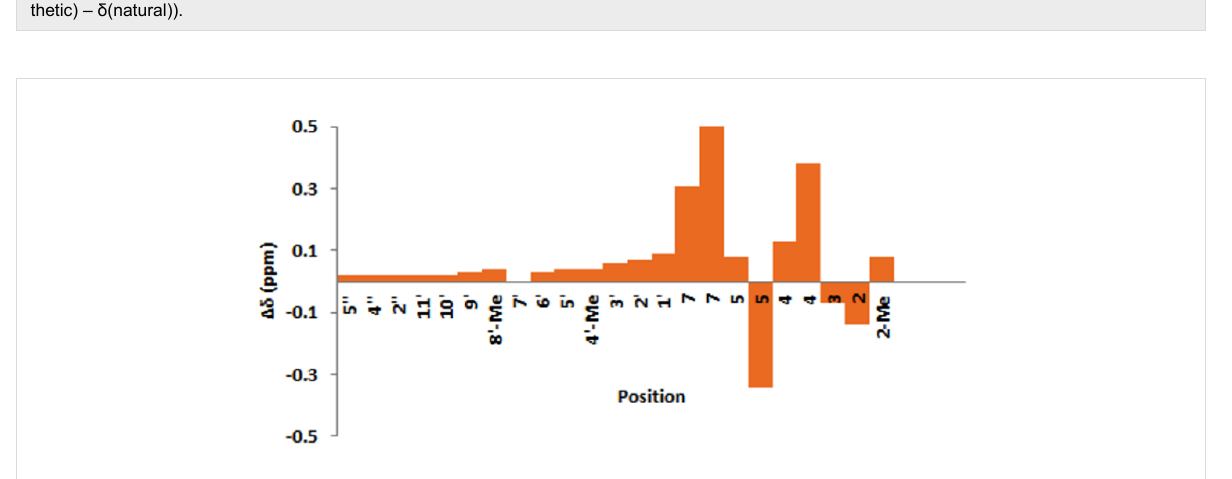
Figure 3: Δδ (ppm) of 1 H NMR chemical shifts in 1’ . Δδ corresponds to the difference in chemical shift for natural and synthetic products ( Δδ = δ (syn- thetic) – δ